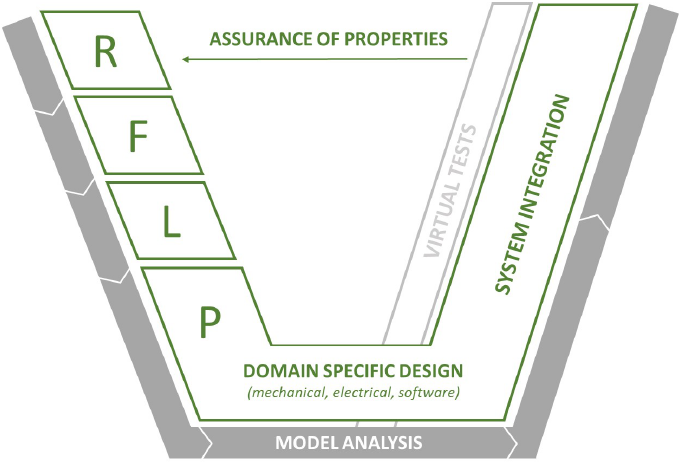
Figure 6. V-model and RFLP